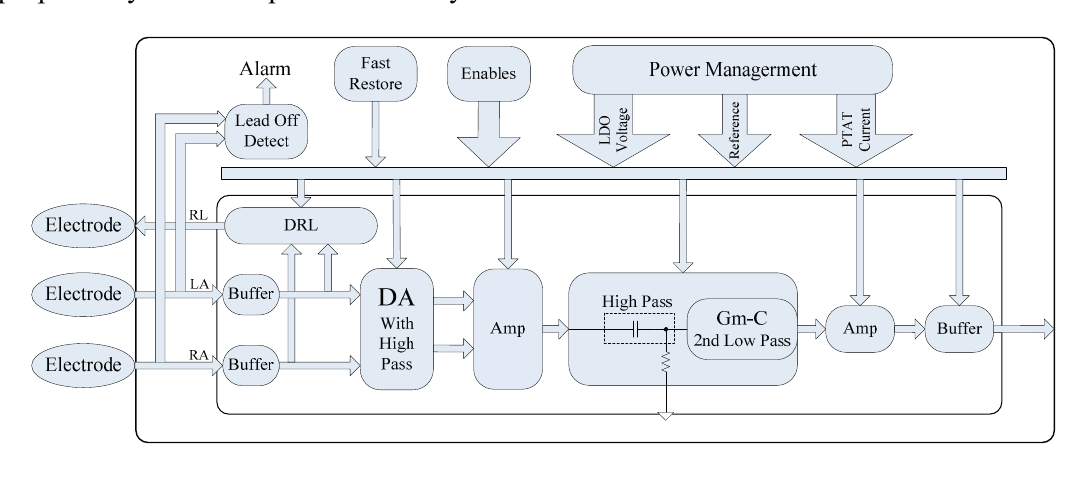
Figure 3. Block diagram of the analog front-end